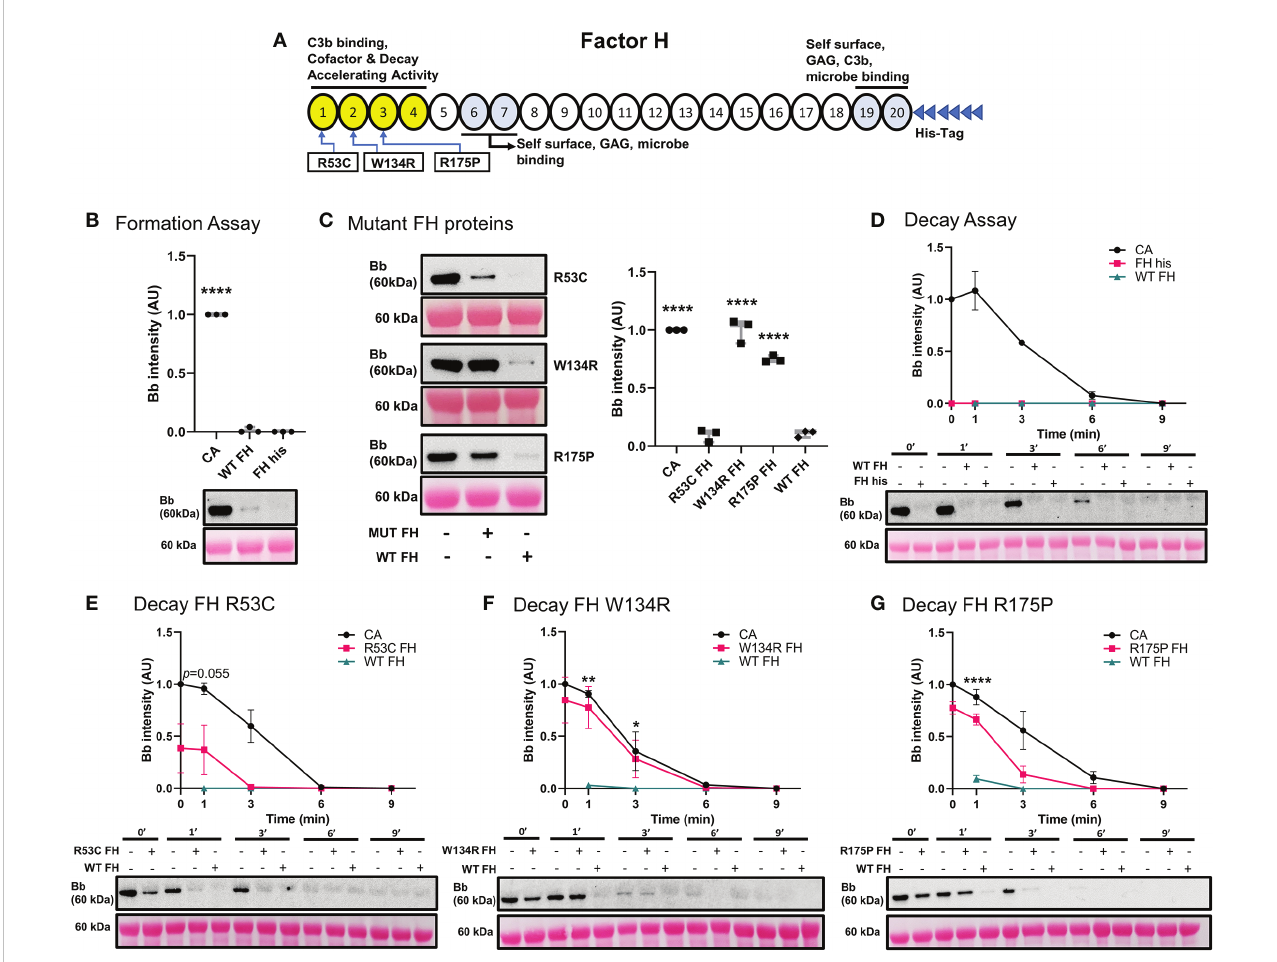
FIGURE 6 Variants in CFH can affect its ability to inhibit C3 convertase formation and promote Decay Acceleration Activity. (A) Schematic of recombinant FH proteins, blue arrows denoting the positions of speci fi c mutants. (B) Western blot analysis of C3 convertase formed alone (CA), or in presence of WT FH or recombinant WT FH (FH his). Recombinant WT FH inhibits C3bBb formation to the same degree as WT FH. (C) Western blot analysis of CA formed alone, or in presence of recombinant FH variants or WT FH. p.Arg53Cys inhibits C3bBb formation to the same degree as WT FH, while p.Trp134Arg and p.Arg175Pro shows signi fi cant impairment in their ability to prevent C3 convertase formation. Results were normalized to CA and presented as relative protein expression. Box plots show median, 1 st and 3 rd quartile ranges, and the individual data points of three independent experiments. Signi fi cance calculated for WT FH. (D) Western blot analysis of CA formed alone, then decayed in buffer, or with WT FH or recombinant WT FH. There is no difference between the two FH conditions. (E) Western blot analysis of CA formed alone, then decayed in buffer, or with p.Arg53Cys or WT FH. p.Arg53Cys almost reached signi fi cance at 1 min as compared to WT FH (p= 0.055 ). (F) Western blot analysis of CA formed alone, then decayed in buffer, or with p.Trp134Arg or WT FH. p.Trp134Arg ( t 1/2 = 2 min , t 1/2 = 2.5 min ) shows very poor DAA, providing only 20% decrease in C3bBb half-life as compared to CA. (G) Western blot analysis of CA formed alone, then decayed in buffer, or with p.Arg175Pro or WT FH. p.Arg175Pro ( t 1/2 ~1.5 min, CA t 1/2 = 3.1 min ) decreases DAA as compared to WT FH. For all decay experiments, results were normalized to CA at 0 min and presented as relative protein expression. Ponceau S Staining was used as a measure of total protein load. Mean±SD of three independent experiments. Statistical signi fi cance shown for comparisons between WT FH/recombinant FH at the same timepoint. * P ≤ 0.05, ** P ≤ 0.01, *** P ≤ 0.001, **** P ≤